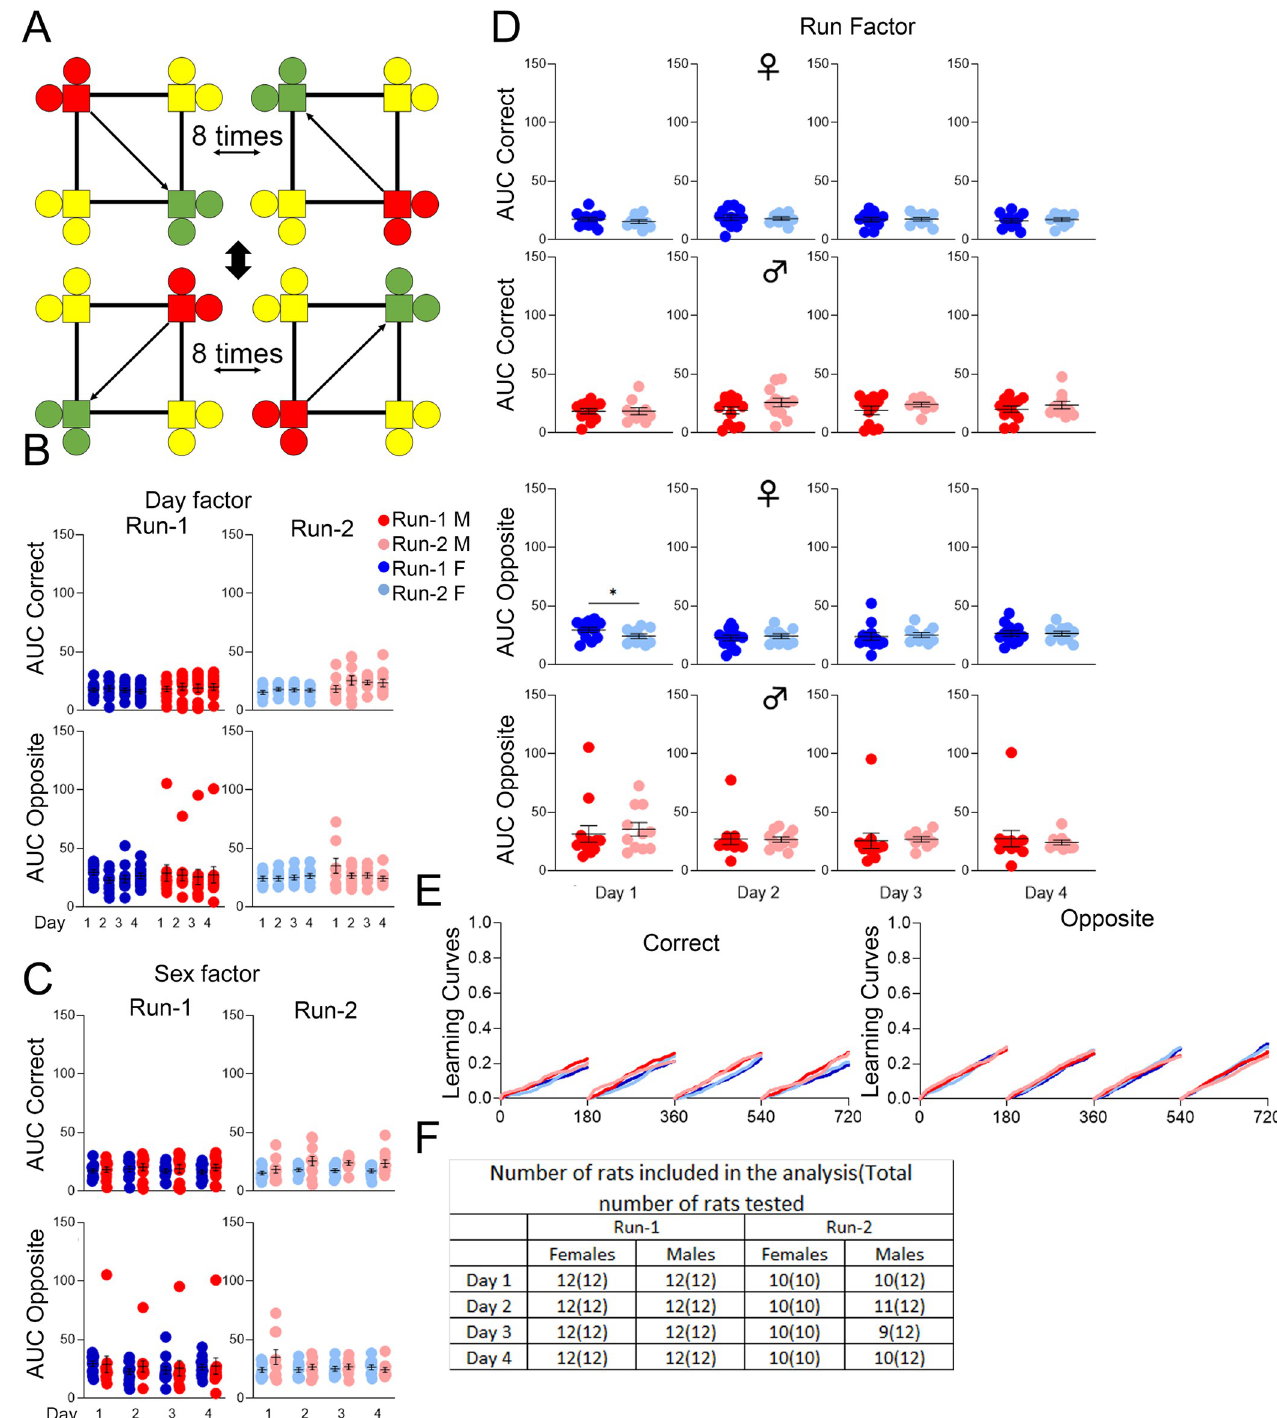
Fig 9. Serial reversal, cohort A. (A) Schematic of correct (green), lateral (yellow), and opposite (red) corner layouts and pattern. The starting layout depends on the initial corner assignment. (B) Day factor, (C) Sex factor and (D) Run factor comparisons of area under the curve (AUC) for activity curves of individual animals by sex, program day, and Run, separated by visit categories (Correct or Opposite). (E) Activity curves showing the fractional accumulation (y-axis) of correct visits or opposite visits over drinking session time (x-axis), reset every 180 minutes, by sex and Run. (F) For Run-1, 12 male and 12 female rats were tested. All 24 rats were included in the analysis of Run-1. For Run-2, 12 male and 10 female rats were tested, since two females died during the time between Runs. Two males were excluded from the analysis of days 1 and 4, one male was excluded from the analysis of day 2, and three males were excluded from the